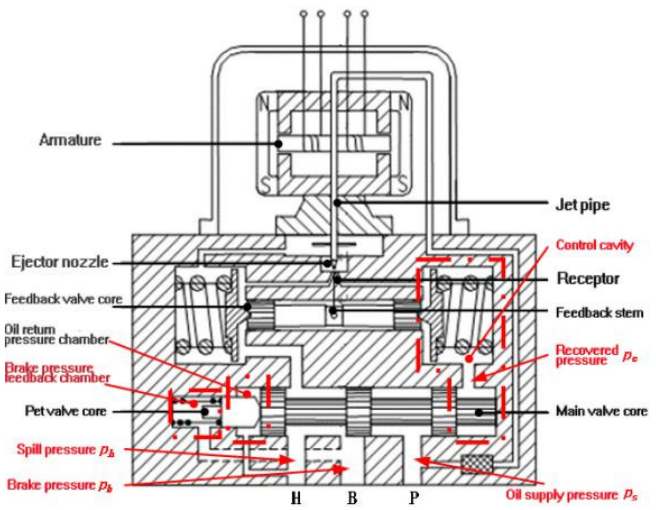
Figure 3. Schematic diagram of the brake pressure servo valve in ABPSVCS.